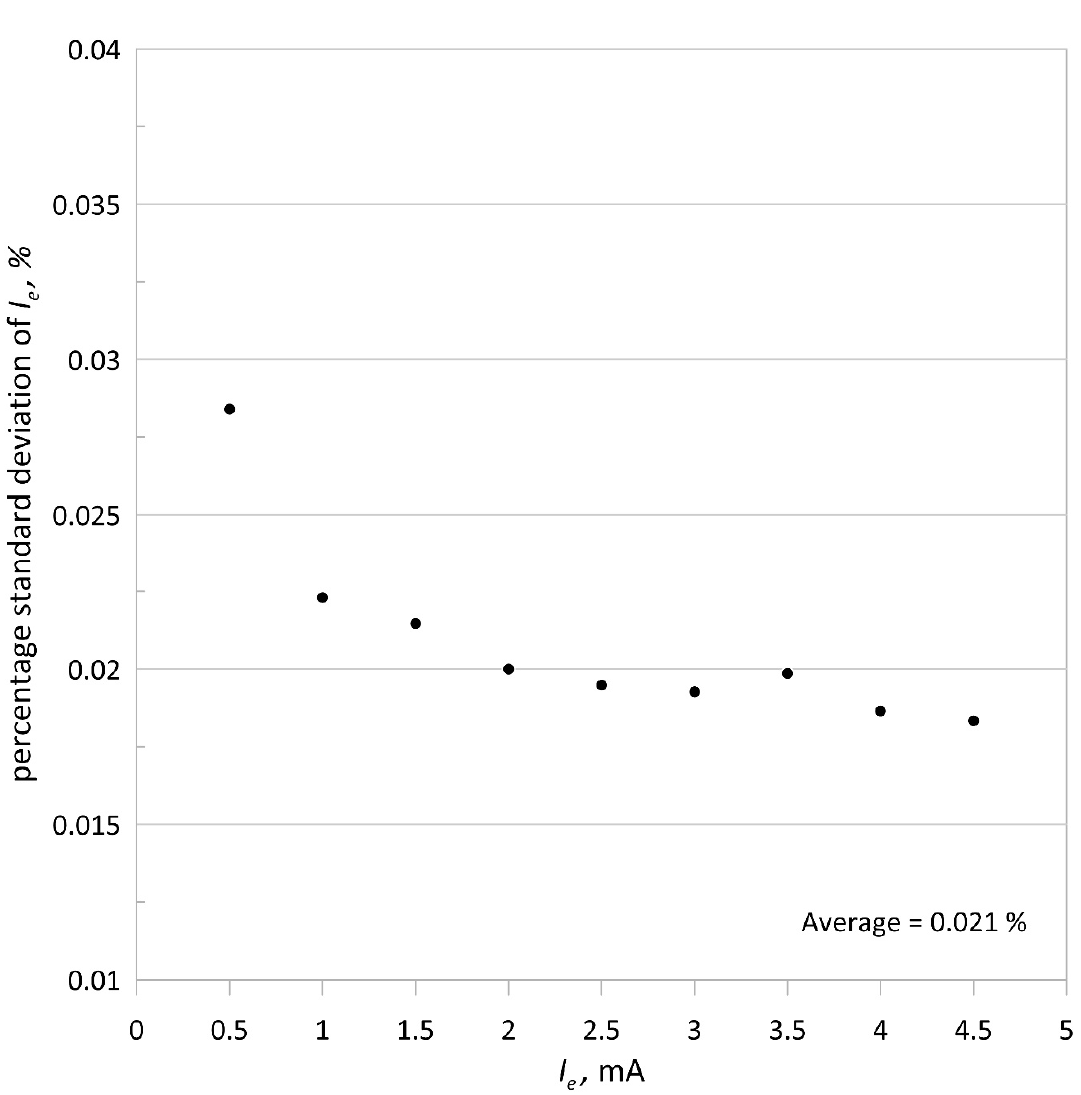
Table 1. Control systems comparison.